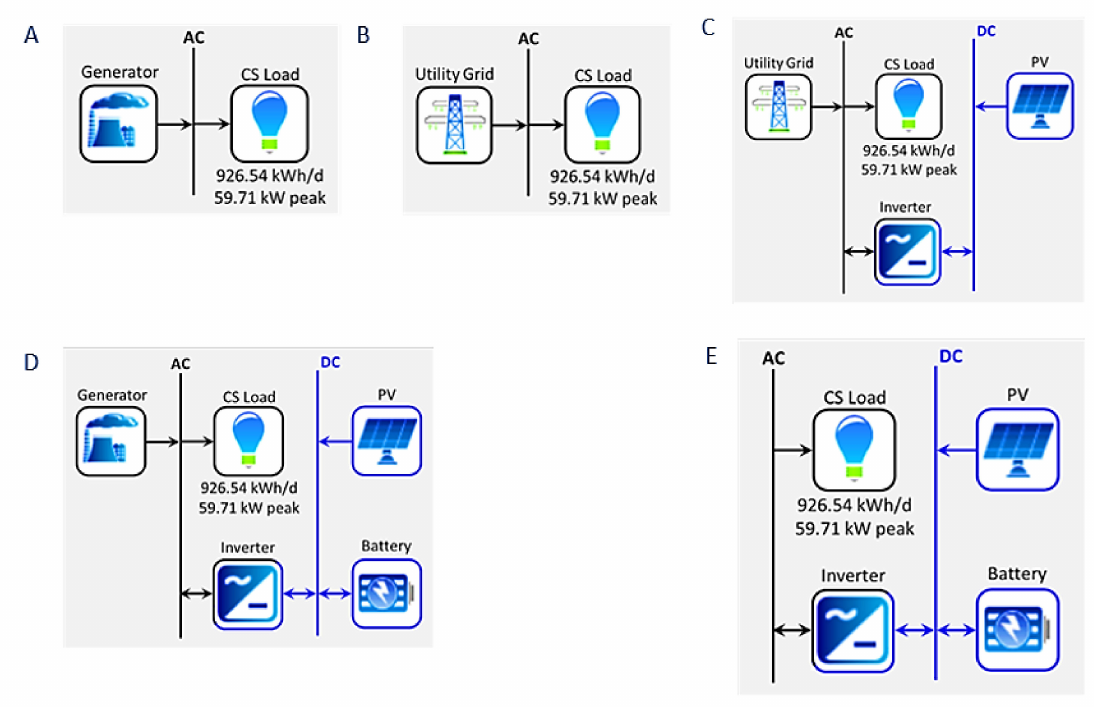
Figure 8. Various Energy System Topologies, ( A ) Generator; ( B ) Utility Grid; ( C ) PV On-grid; ( D ) PV Hybrid with Generator; ( E ) PV Off-grid